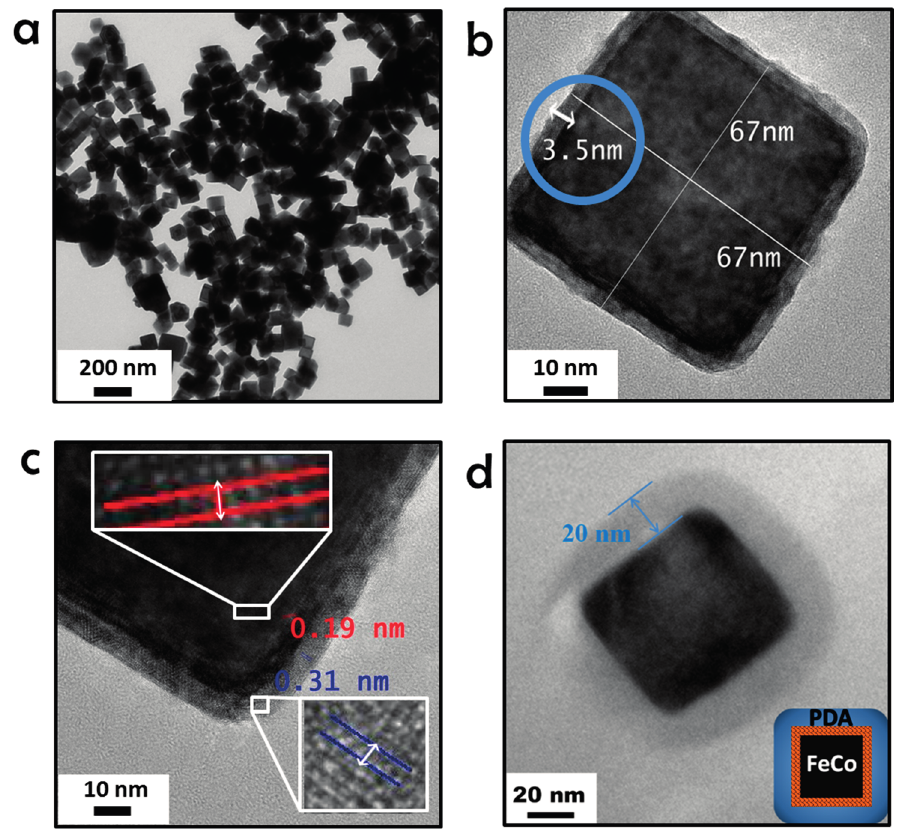
Figure 1. ( a ) TEM images of the as prepared FeCo NCs; ( b ) HR-TEM image of FeCo·(Fe,Co) x O y NCs after oxidation in toluene; ( c ) oxide shell is 3.5 nm on HR-TEM image of the FeCo·(Fe,Co) x O y NCs with zoomed areas of crystal lattices distances for metal core (red) and oxide shell (blue); ( d ) TEM image of PDFC with 20 nm polydopamine